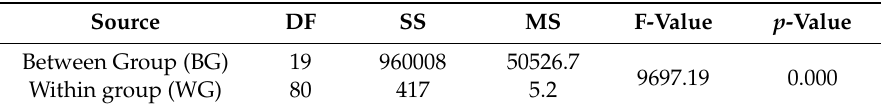
Table 4. The ANOVA test results of tensile strength.